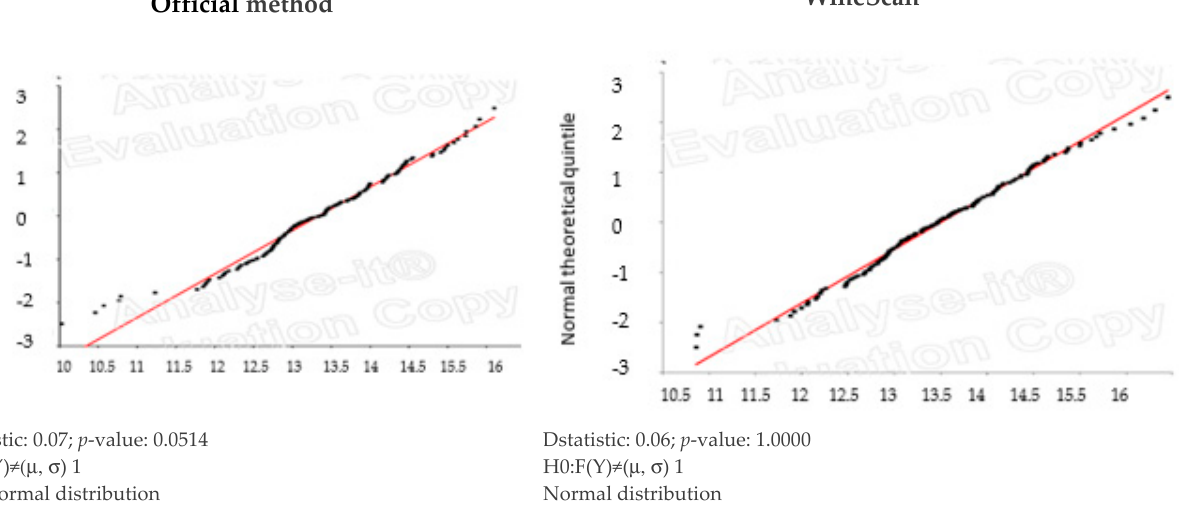
Figure 7. Statistical differences (Kolmogorov–Smirnov test) between alcohol concentration results obtained by the official method and WineScan technology. The continuous line represents the normal distribution. The dashed dots represent the observed distribution.